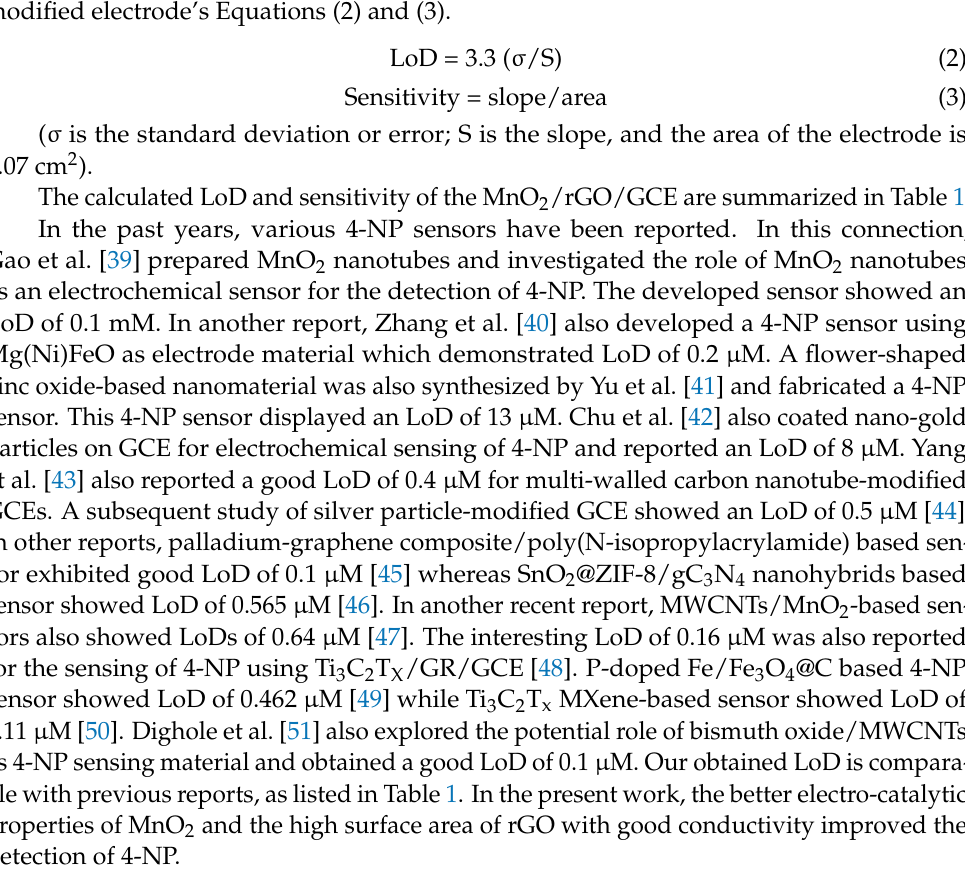
Table 1. Comparison of reported 4-NP sensors with MnO 2 /rGO/ GCE’s performance